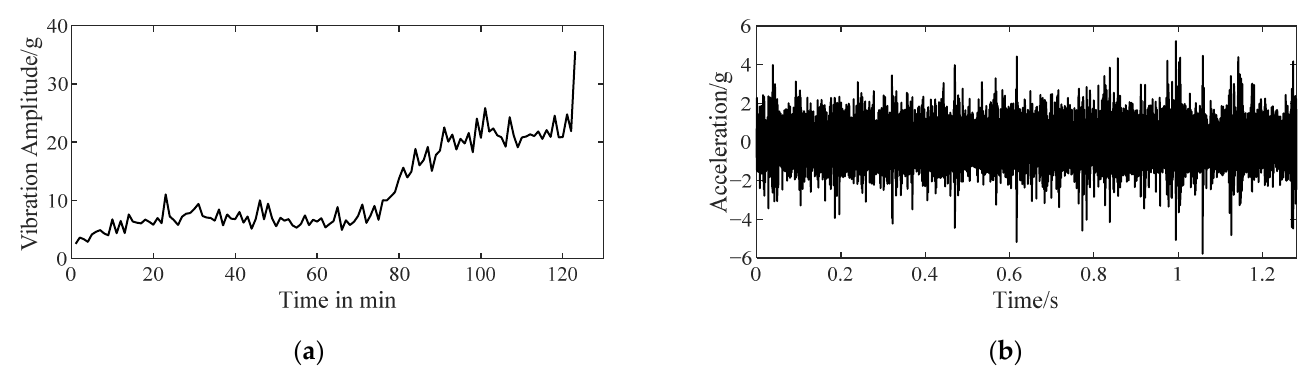
Figure 9. Vibration data of bearing 3. ( a ) The curve of maximum vibration amplitude versus time; ( b ) vibration signal measured at 66th min (initial fault).